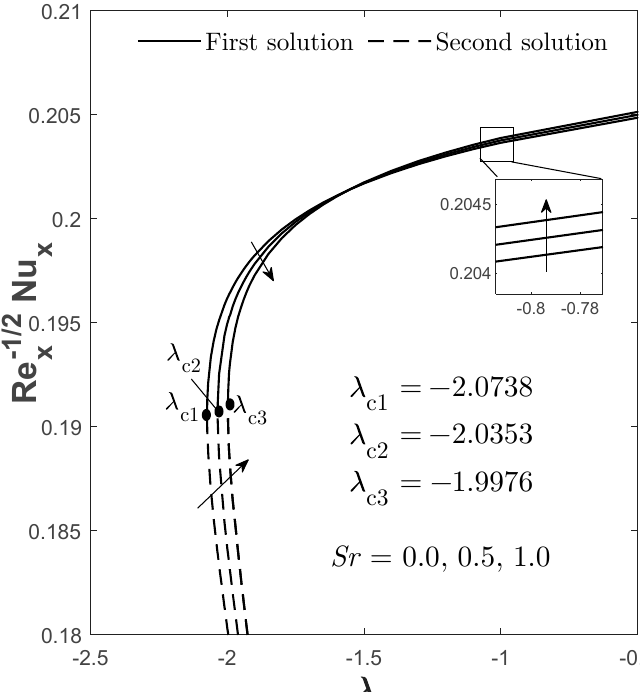
Figure 9. Re − 1/2 x Nu x for varied Sr when N = Rd = Sc = 1, φ 2 = 0.01, Du = 0.03, and Bi = Figure 9. for varied Sr when